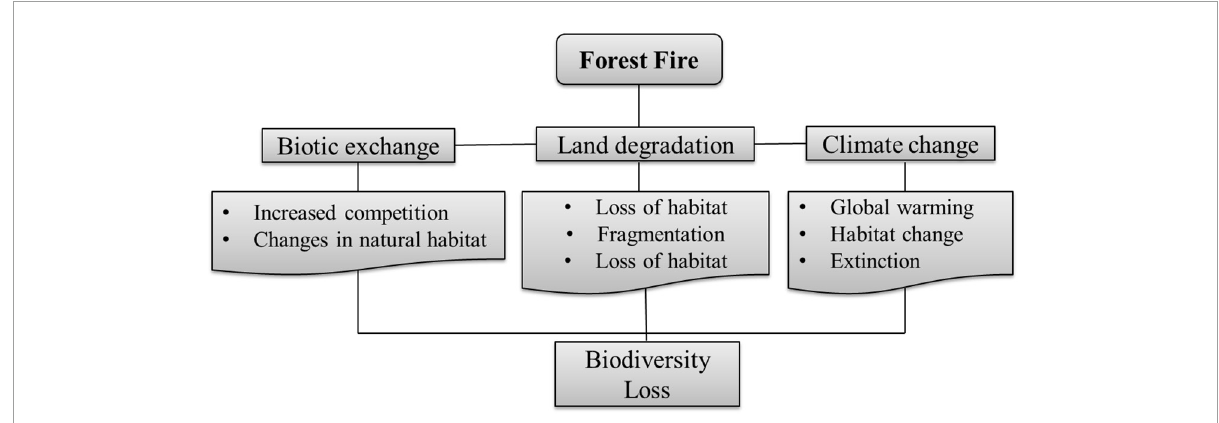
FIGURE3 Negative impact of forest